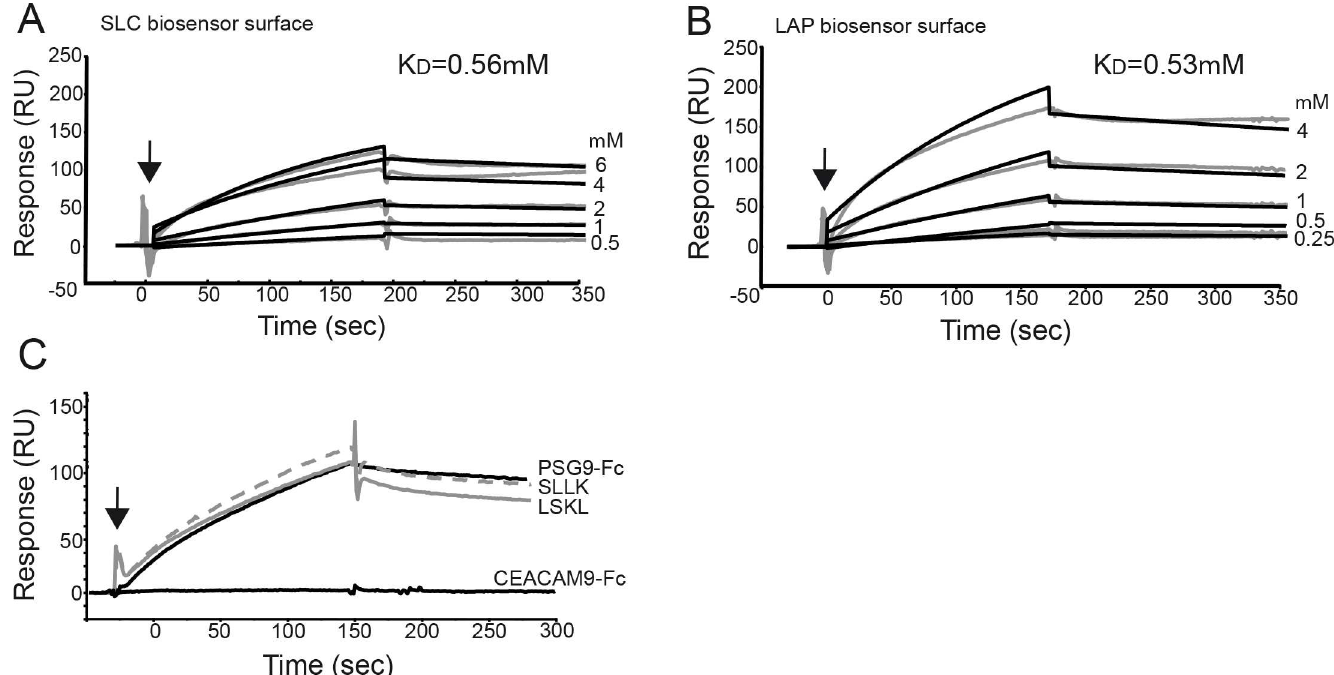
Fig 2. PSG9 interacts with SLC and LAP of TGF- β 1. Purified PSG9-Fc protein was injected at a concentration range from 0.25 to 6 μ M over a CM5 sensor chip with immobilizedSLC (A) and LAP (B) of TGF- β 1. PSG9-Fc injectionpoint is indicatedwith an arrow and the KD values for each interaction are shown. SPR sensograms for each responseare shown as gray lines while fit analysesare shown as black lines. C. PSG9-Fc at 2 μ M was incubated with the LSKL peptideantagonistof thrombospondin-1or a control peptide(SLLK) before injectionover a CM5 sensor chip with immobilizedLAP. Sensogramfor CEACAM9 injected over the LAP biosensoris also shown as a control. RU, responseunits.